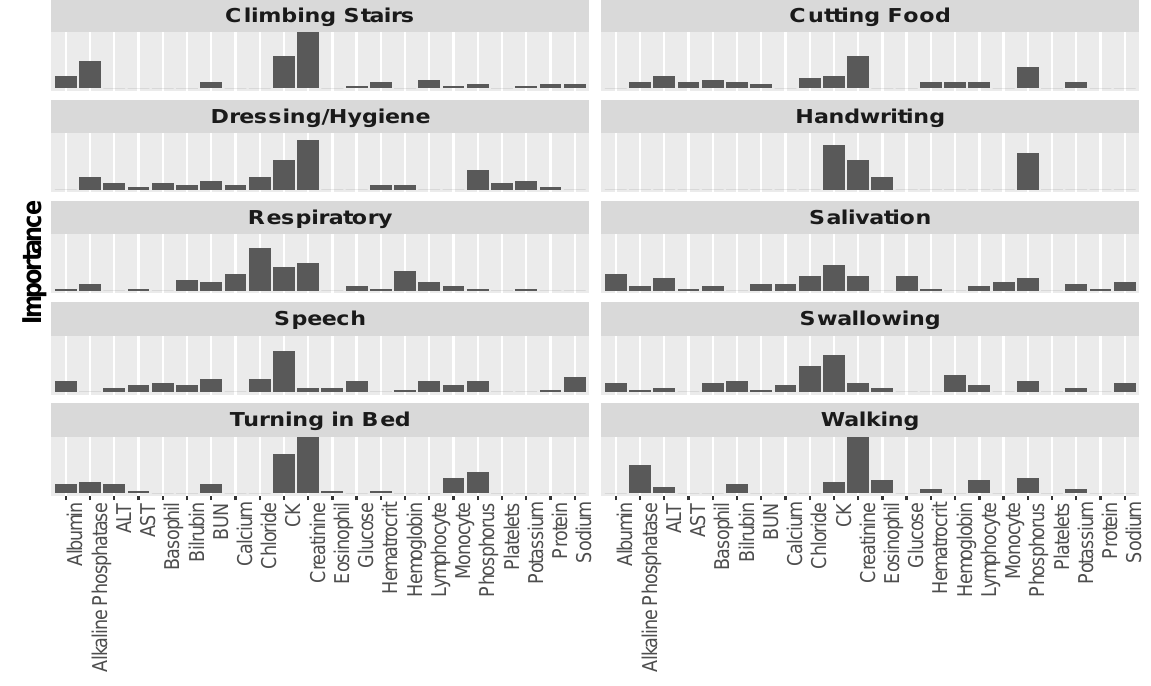
Figure 6. Predictor importance among the laboratory variables for each of the ALSFRS